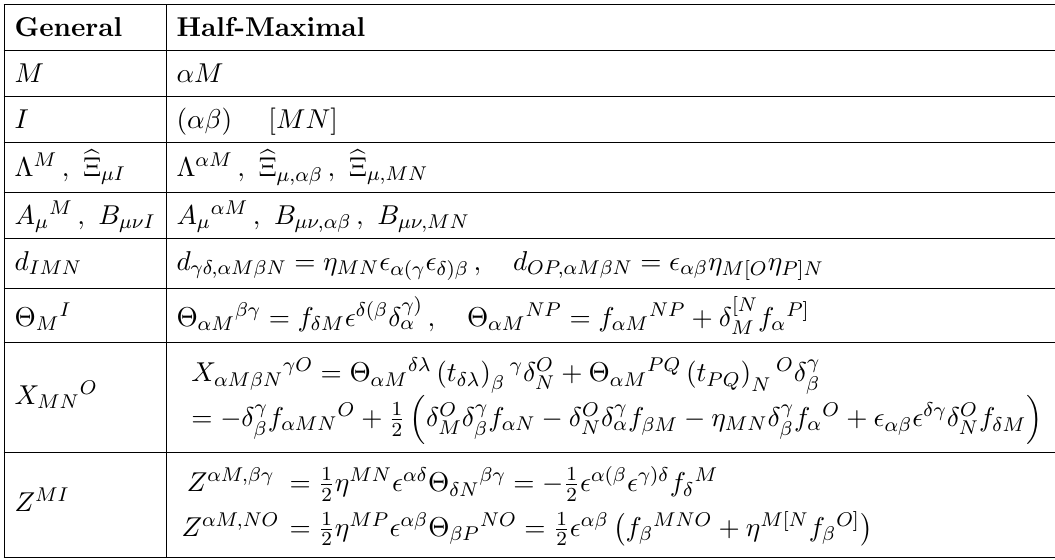
Table 5 . Identi(cid:12)cation between tensors in the general structure of the tensor hierarchy (section 5.2) and the n = 4 half-maximal gauged